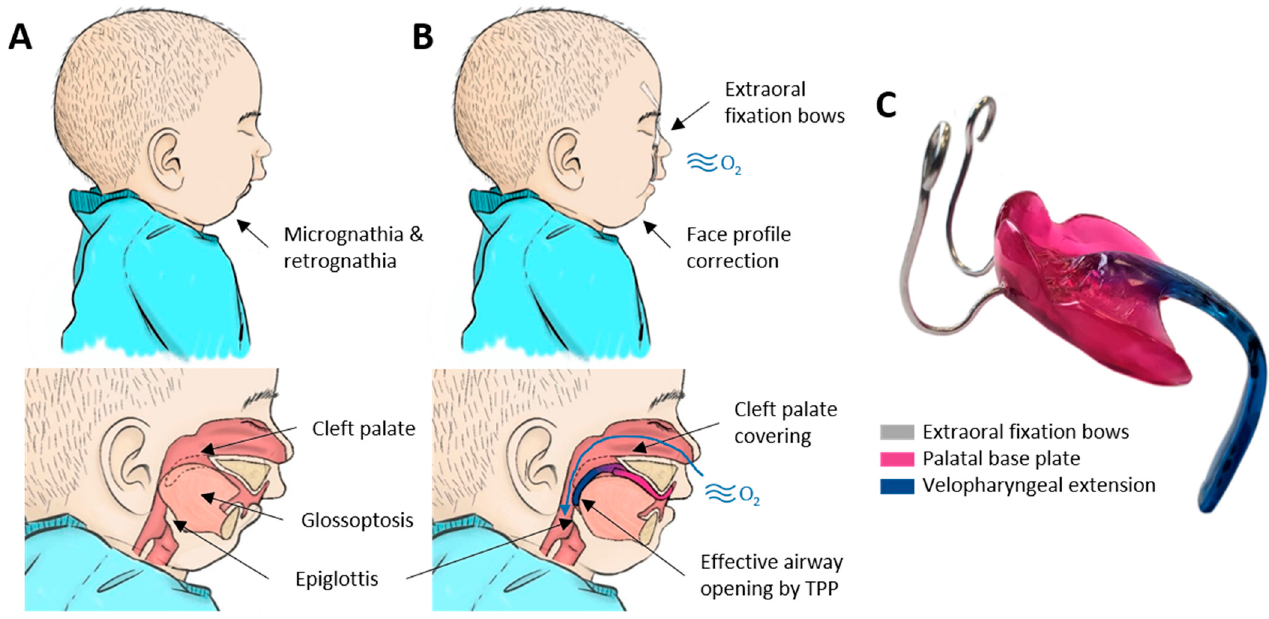
Figure 1. Robin sequence (RS) and its respective treatment by the Tübingen Palatal Plate (TPP). ( A ) RS is characterized as the combination of mandibular retrognathia, glossoptosis, and in the majority of the cases, a cleft palate, which all result in upper airway obstruction. ( B ) Correct placement of TPP leads to the subsequent airway opening and correct mandible positioning. ( C ) Example of an individualized TPP and its respective parts.